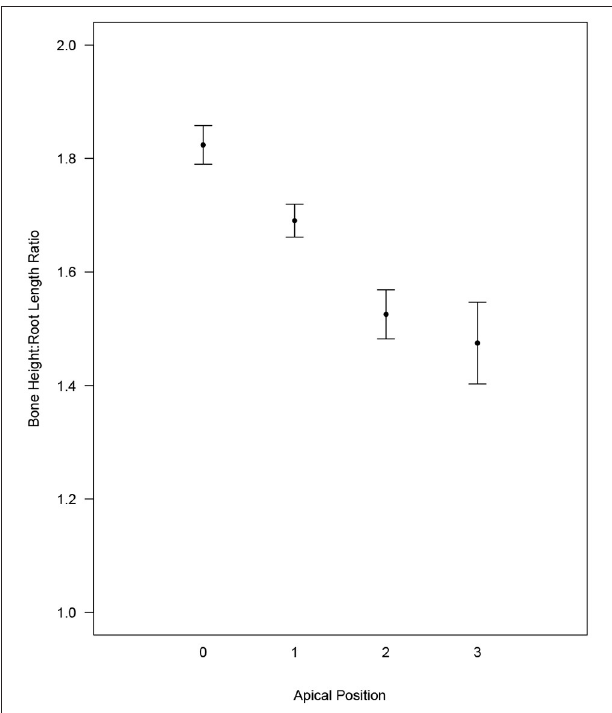
FIGURE 2 | Estimated average ratio with CI for each apical position while controlling for multiple measures within each dog and for Side and Root. All two-way comparisons are statistically significant (Tukey p < 0.001) except for 2 vs. 3 (Tukey p = 0.476).